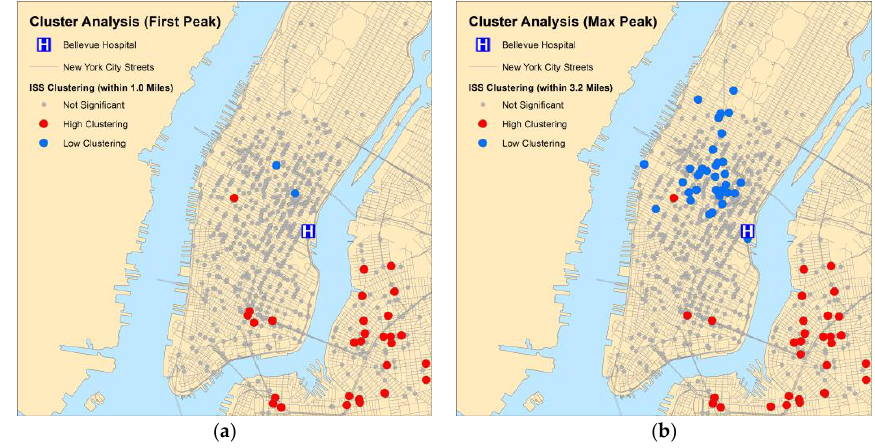
Figure 3. Clustering of high ISS and low ISS among bicyclist trauma incidents. Legend: Results of the clustering analysis of high injury severity scores (ISS) and low ISS based on Anselin Local Moran’s I analysis. The above depicts statistically significant high-to-high clusters and low-to-low clusters for bicyclist injuries using the distance band at the ( a ) first and ( b ) maximal peaks of significance for incremental spatial autocorrelation.